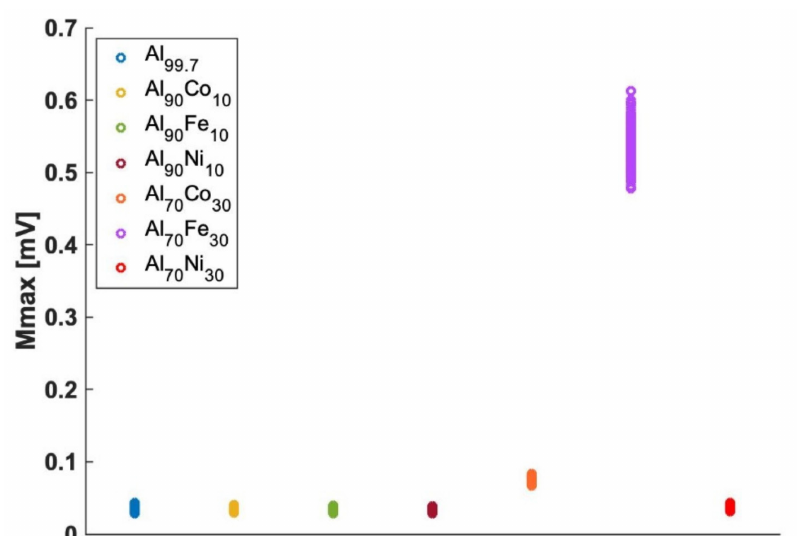
Figure 10. Characteristic value Mmax of the Barkhausen noise analysis for the hybrid materials, whereby magnetic feedback could be delectated by the addition of 30 mass-% Fe and